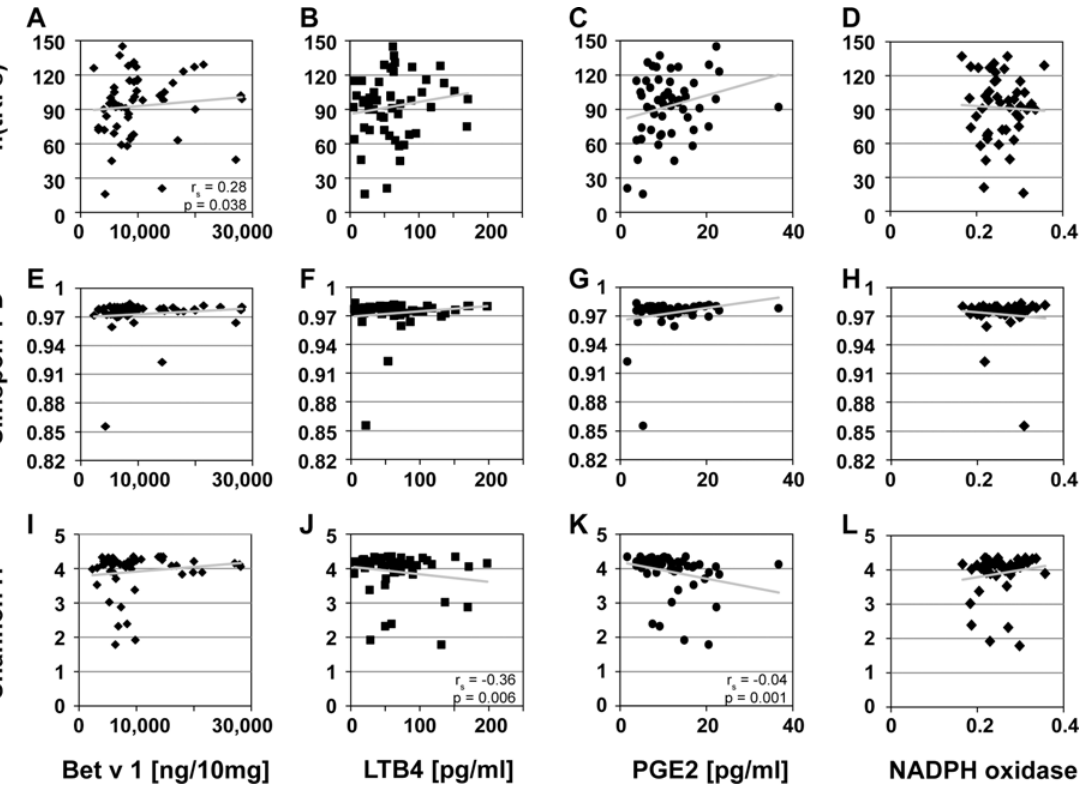
Fig 5. Spearman correlations of bacterial diversity on birch pollen to allergenicity parameter. Scatterplot including linear trend line, spearman correlation values rho and significance level p of diversity indices (Shannon H/Simpson 1-D) and parameter (number of fragments n(tRFs)) of bacterial pattern on birch pollen ( Betula pendula 2014, n = 55) with allergen concentration in pollen. A-D) Correlation of n(tRFs) and allergenicity parameters Bet v 1 (r s = 0.28, p = 0.038), PALM LTB4 (r s = 0.14, p = 0.33), PALM PGE2 (r s = 0.17, p = 0.22) and NADPH oxidase (r s = -0.04, p = 0.79). E-H) Correlation of Simpson diversity Index 1-D and allergenicity parameters Bet v 1 (r s = 0.25, p = 0.068), PALM LTB4 (r s = 0.08, p = 0.53), PALM PGE2 (r s = .12, p = 0.366) and NADPH oxidase (r s = 0.2, p = 0.19). I-L) Correlation of Shannon diversity Index H and allergenicity parameters Bet v 1 (r s = 0.14, p = 0.317), PALM LTB4 (r s = -0.36, p = 0.006), PALM PGE2 (r s = -0.04, p = 0.0015) and NADPH oxidase (r s = 0.2, p = 0.19).